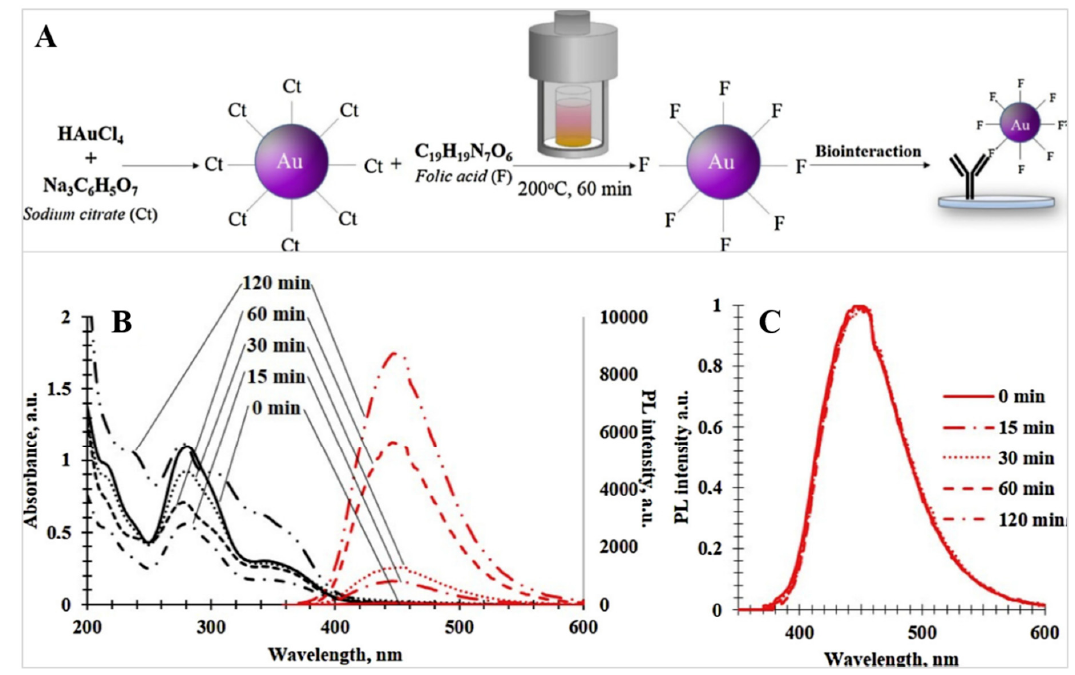
Figure 3. Scheme of GNPs synthesis, functionalization, and interaction with antibody ( A ); the absorbance (black) and emission (red) maxima of FA solutions after hydrothermal treatment at a different time ( B ); normalized emission spectra ( C ) (Adapted with permission from Reference [45], Copyright (2019)